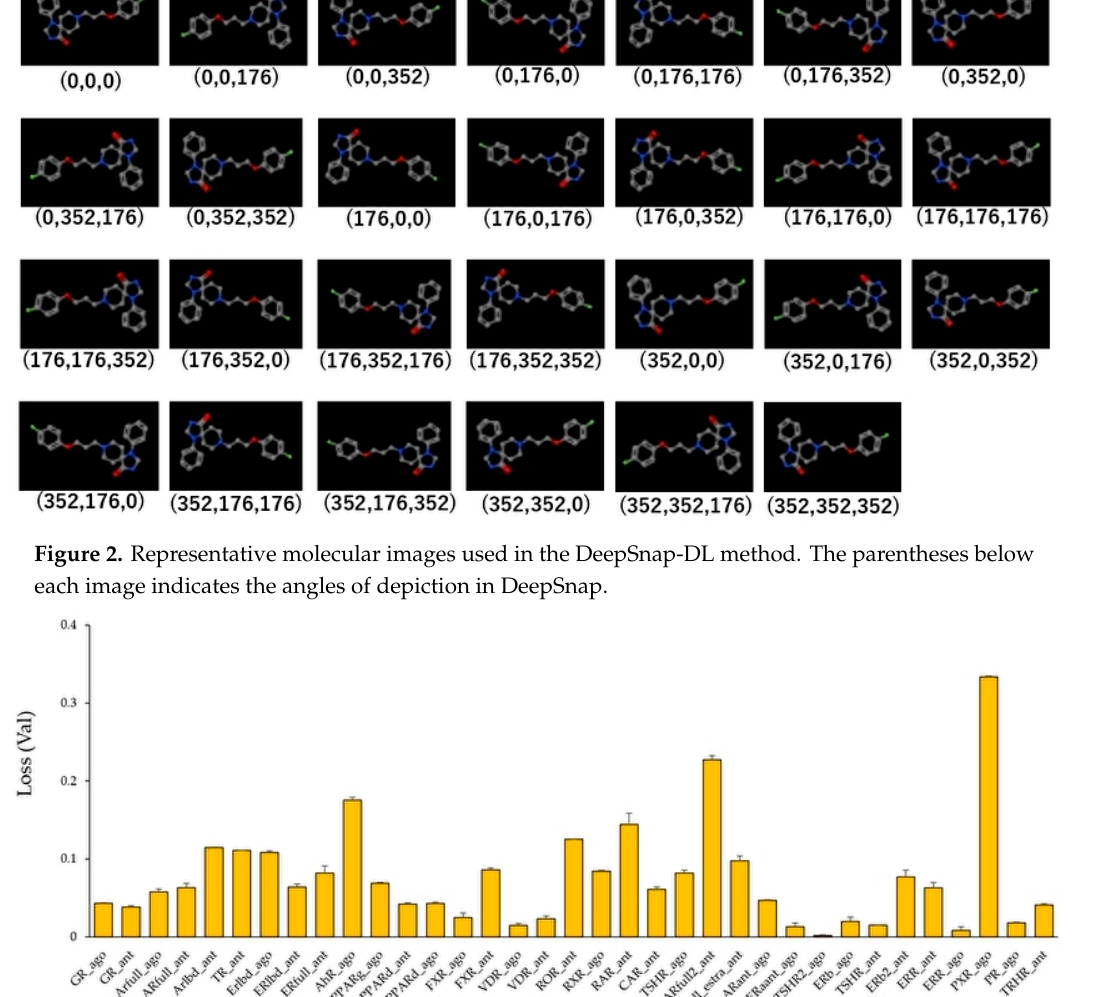
Figure 4. Average Matthews correlation coefficient (MCC) (top) and area under the curve (AUC) (bottom) values in the Test dataset in the models of 35 NR agonists and antagonists constructed by DeepSnap-DL. n = 2. Each bar indicates average MCC and AUC ± standard error.